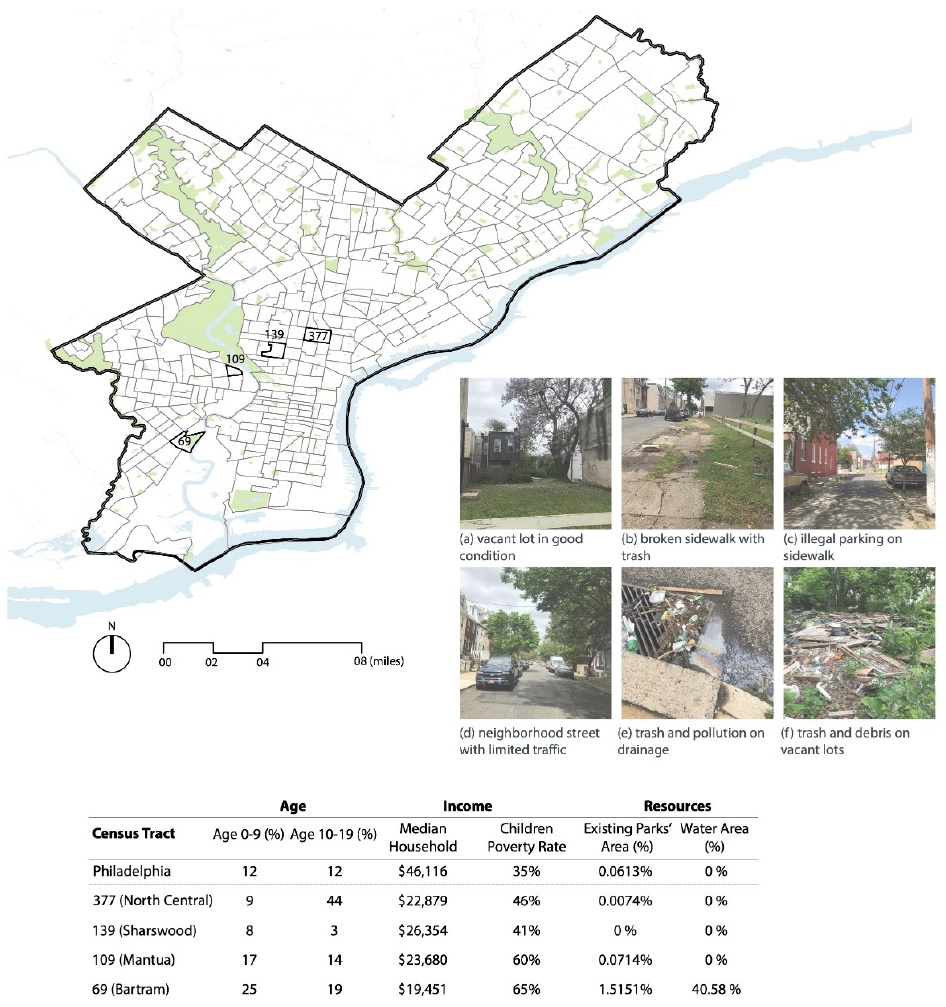
Figure 2. Census Tract 377 (Philadelphia, PA, USA) was chosen as the study area based on demographics, income, and natural resources conditions.